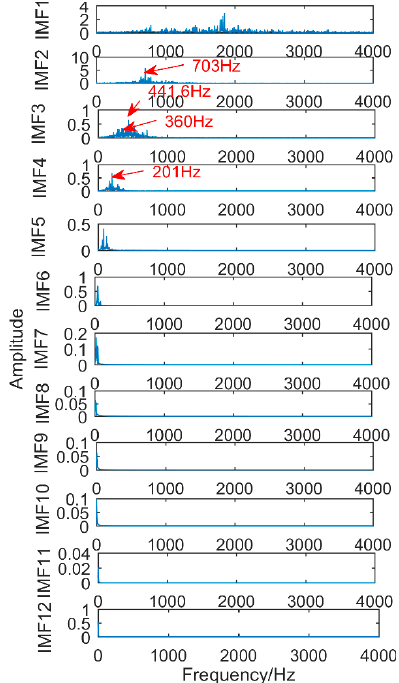
Figure 31. Frequency domain diagram of decomposition results obtained by EEMD.